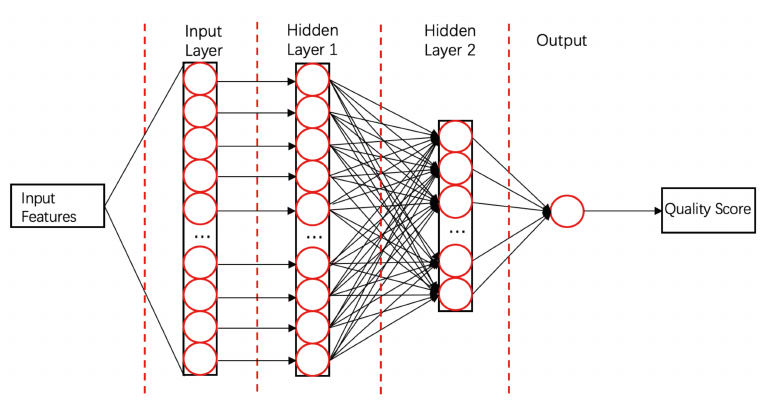
Figure 4. Diagram of the NN used by ProQ3D. Hidden Layers 1 and 2 contain 600 and 200 cells,